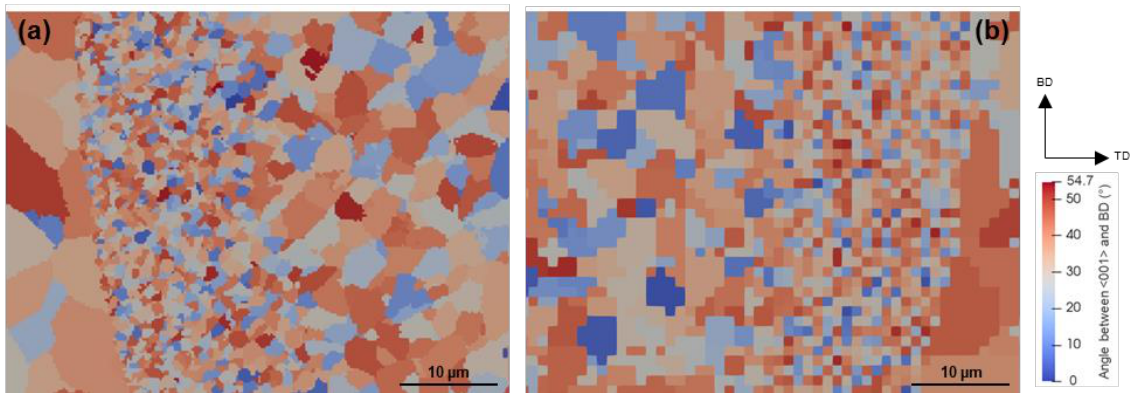
Figure 13. Detailed microstructures of the highlighted areas in Figure 12; ( a ) semi-2D simulation with a cell size of 250 nm and ( b ) 3D simulation with a cell size of 1 µm.